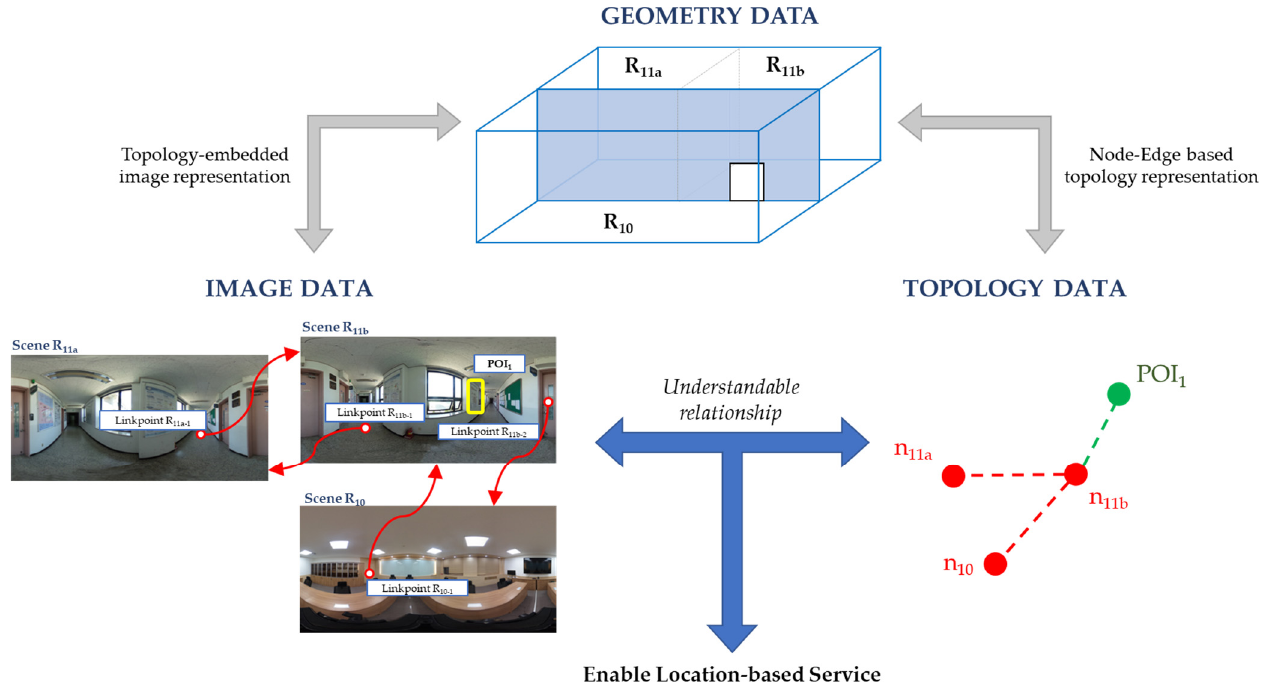
Figure 8. Concept of establishing relationships between the image and topological spatial data.